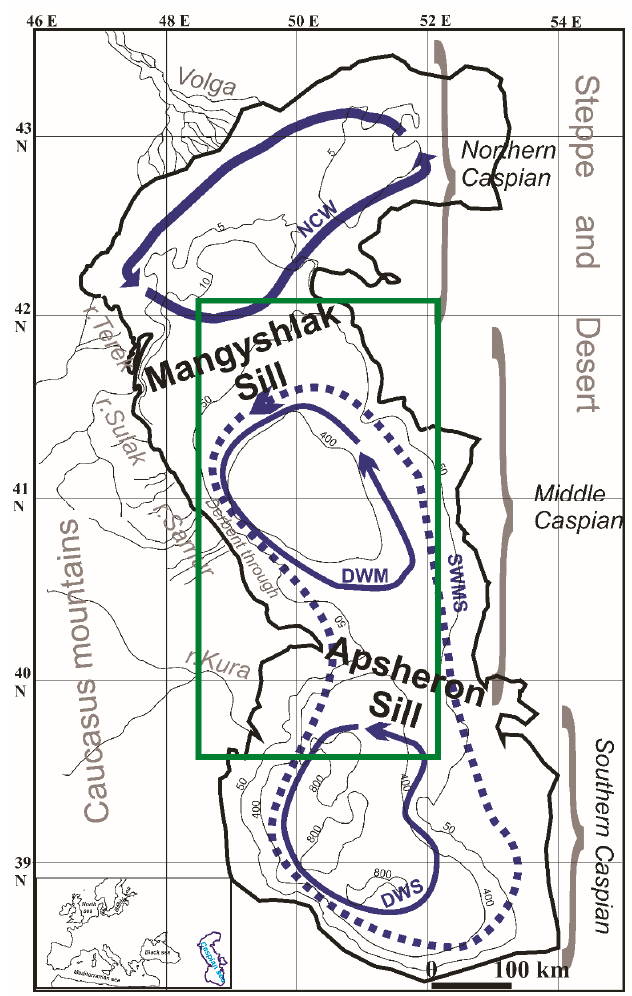
Figure 1. Bathymetric map (m) of the Caspian Sea with regional divisions (northern, middle, and southern) and major geographical sites (mountains, rivers, and steppe). Major bottom currents: NCW (north CS water mass which takes all water levels), SWMS (surface-water mass of the middle and south Caspian sub-basins), DWM (deep water mass of the middle Caspian sub-basin), DWS (deep-water mass of south Caspian sub-basin); river system of the Caucasus Mountains in the west and the Volga River delta in the north are shown. Rectangle shows the area of seismic surveys performed between 2004 and 2012.